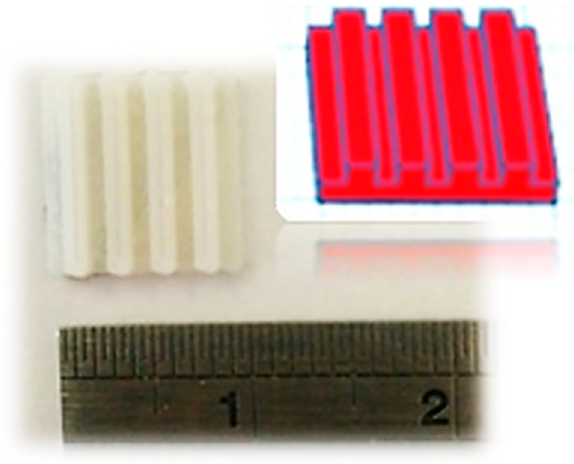
Figure 1. Representative image of the 3D-printed structures/scaffolds.